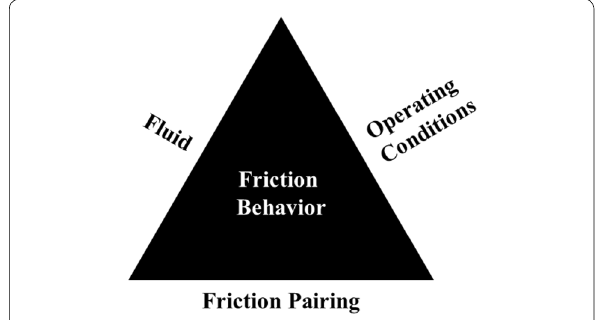
Figure 1 Tribological system—schematic